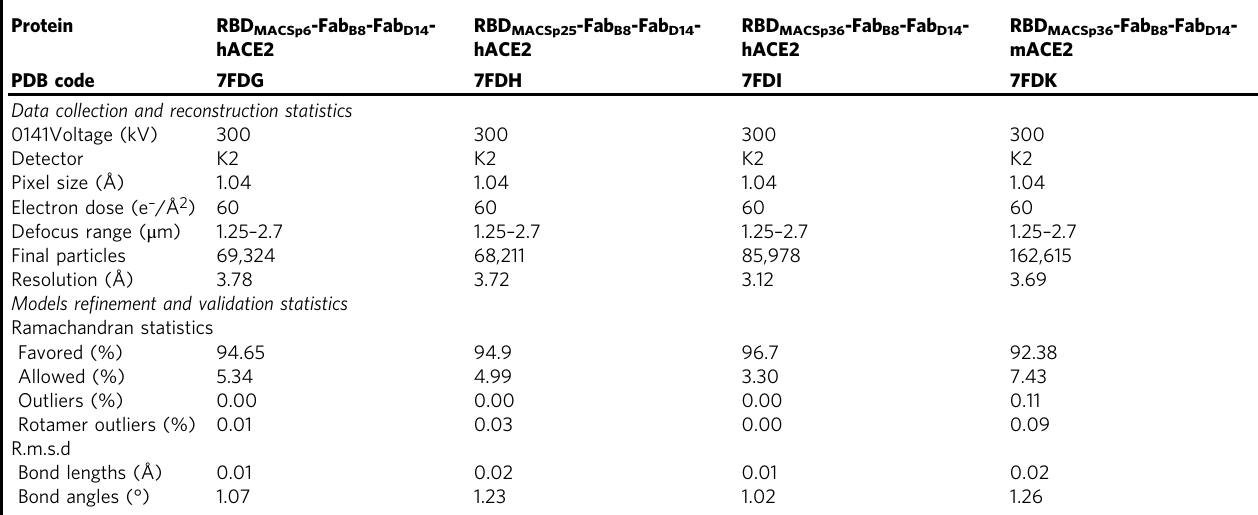
Table 1 Cryo-EM data collection and atomic model re fi nement statistics.